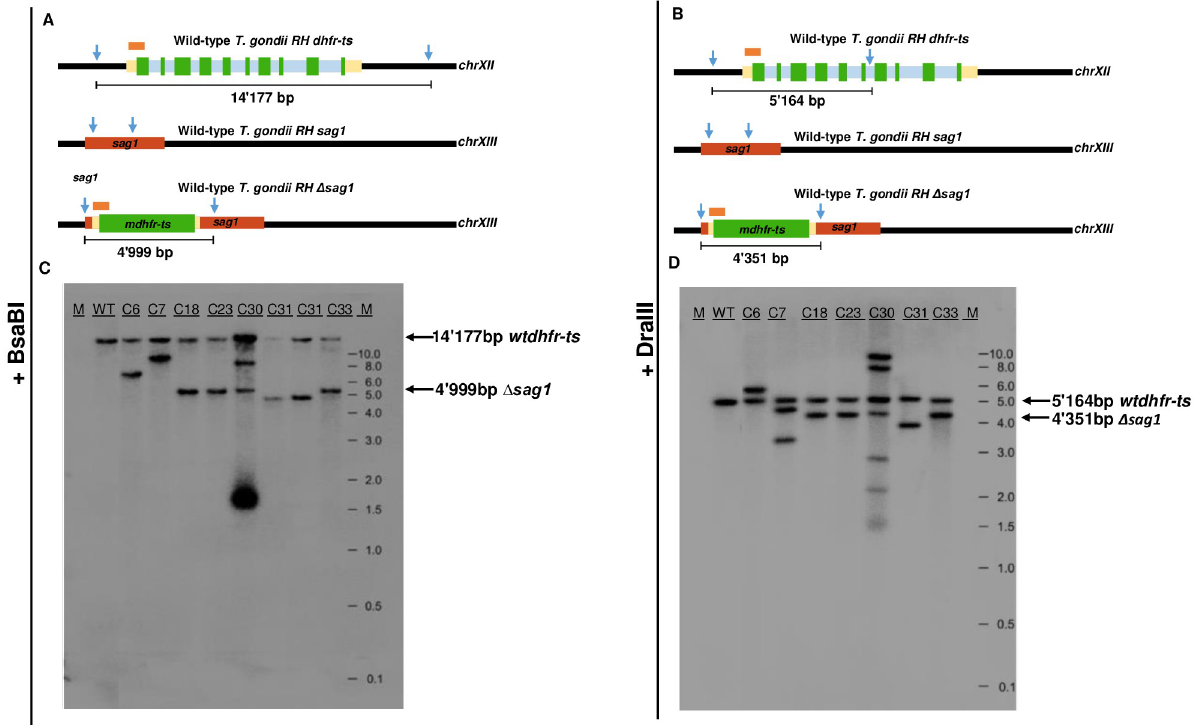
Fig 7. Southern blot analysis for determining the number of mdhfr-ts integration events into the T . gondii RH genome. ( A ) and ( B ) Schematic drawing of hybridization probe and restriction sites of BsaBI and DraIII in the WT T . gondii RH dhfr-ts gene and in the WT and mutant sag1 locus. ( C ) Southern blot of genomic DNA digested with BsaBI and ( D ) with DraIII. M indicates the size of the fragments separated by gel electrophoresis.